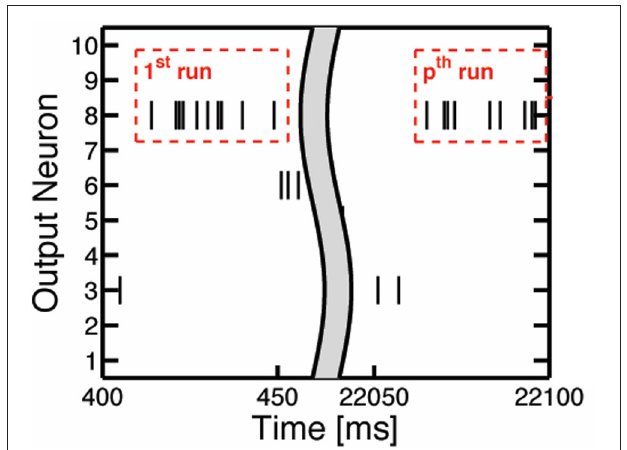
FIGURE 5 | The illustration of consecutive output spikes of 10 output neurons as a representative example. The consecutive output spikes of Neuron 8 are boxed in